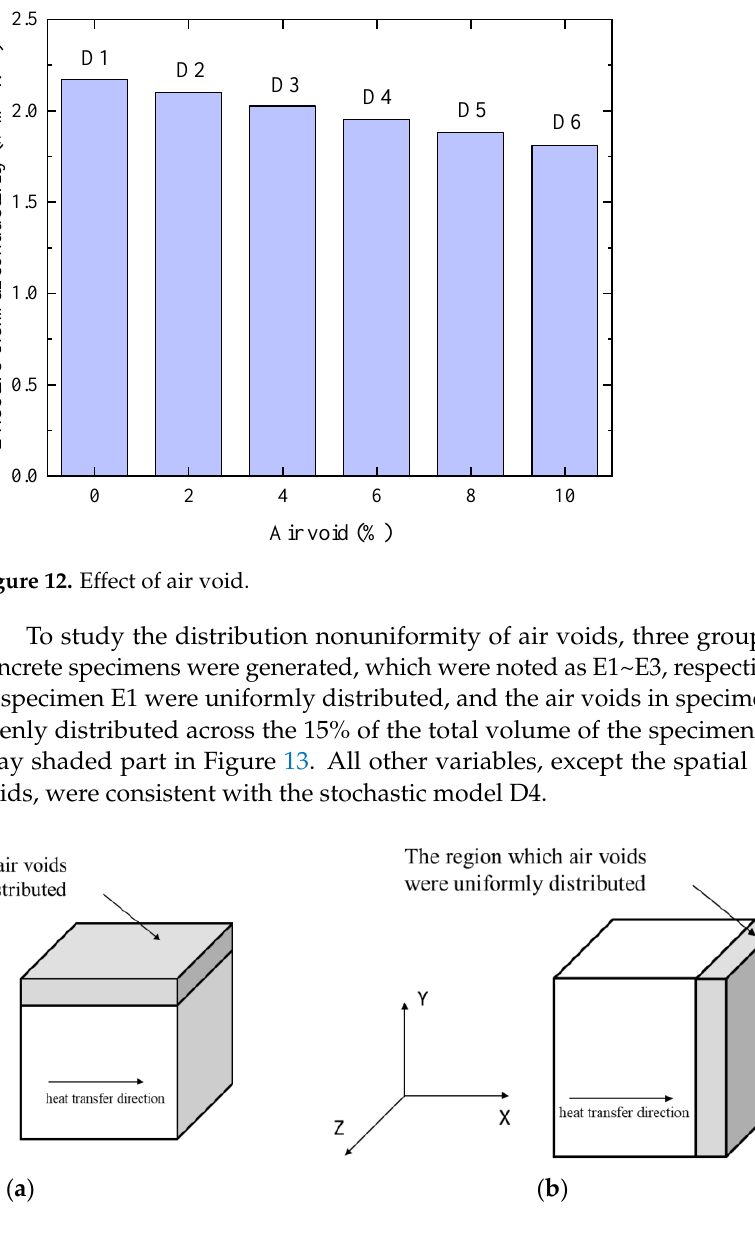
Figure 13. Schematic diagram of air voids distribution in specimen ( a ) E2 and ( b ) E3. Figure 14 illustrates the predicted effective thermal conductivity from each model. This study found that the air void distribution of asphalt concrete affects its thermal conductivity. Compared with the uniform model (E1), when the pores perpendicular to the thermal conductivity calculation direction (E2) are nonuniform, the effective thermal conductivity will increase, and when the pores parallel to the thermal conductivity calculation direction (E3) are nonuniform, the effective thermal conductivity will decrease.